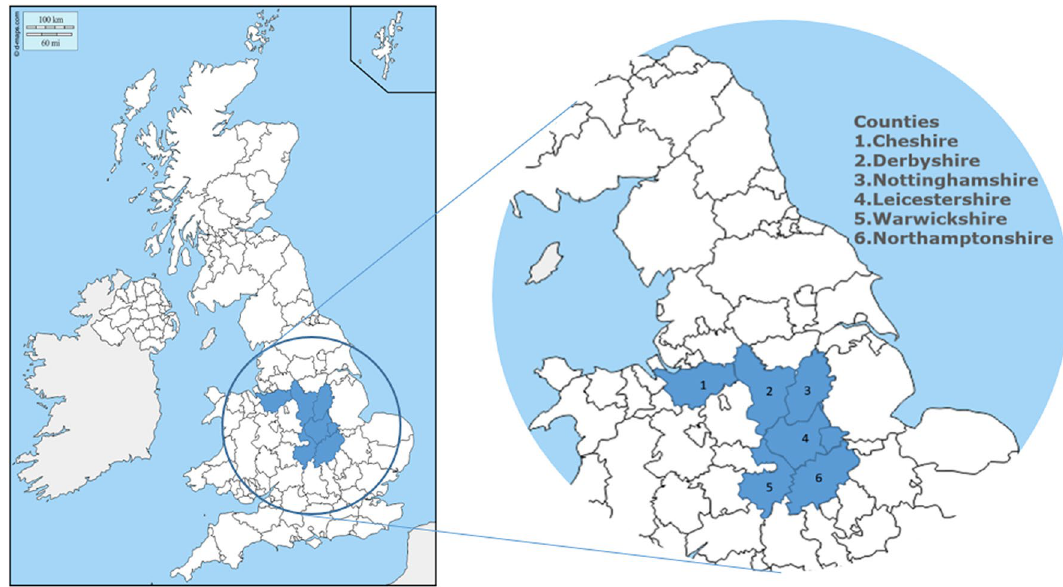
Figure 1. Map of the counties where RTA badgers were collected for